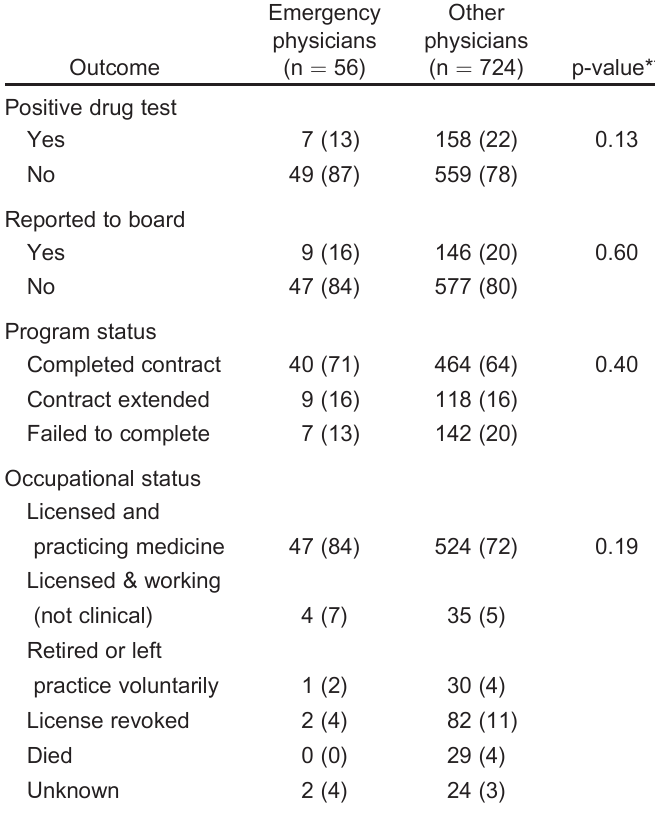
Table 2. Drug-testing outcomes and program and occupational status of emergency physicians and other physicians at 5-year follow up of being in a state physician health program for substance use disorders. *